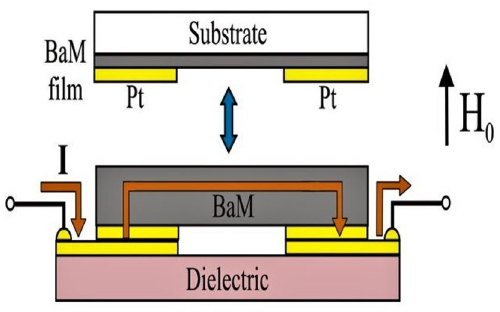
Figure 1. Schematic diagram showing the experimental setup for the investigation of the nonlinear magnetoelectric (NLME) effects in barium hexaferrite for the in-plane